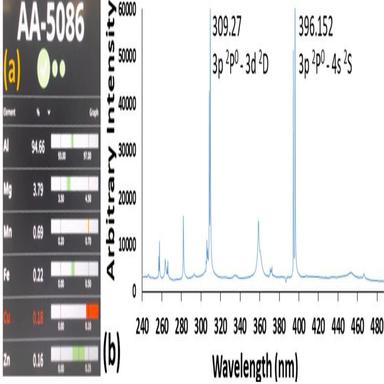
Hitachi High Tech LIBS, (a) on screen report of aluminium alloy grade fit of key elements sent back to the control room software, (b) example aluminium spectrum.